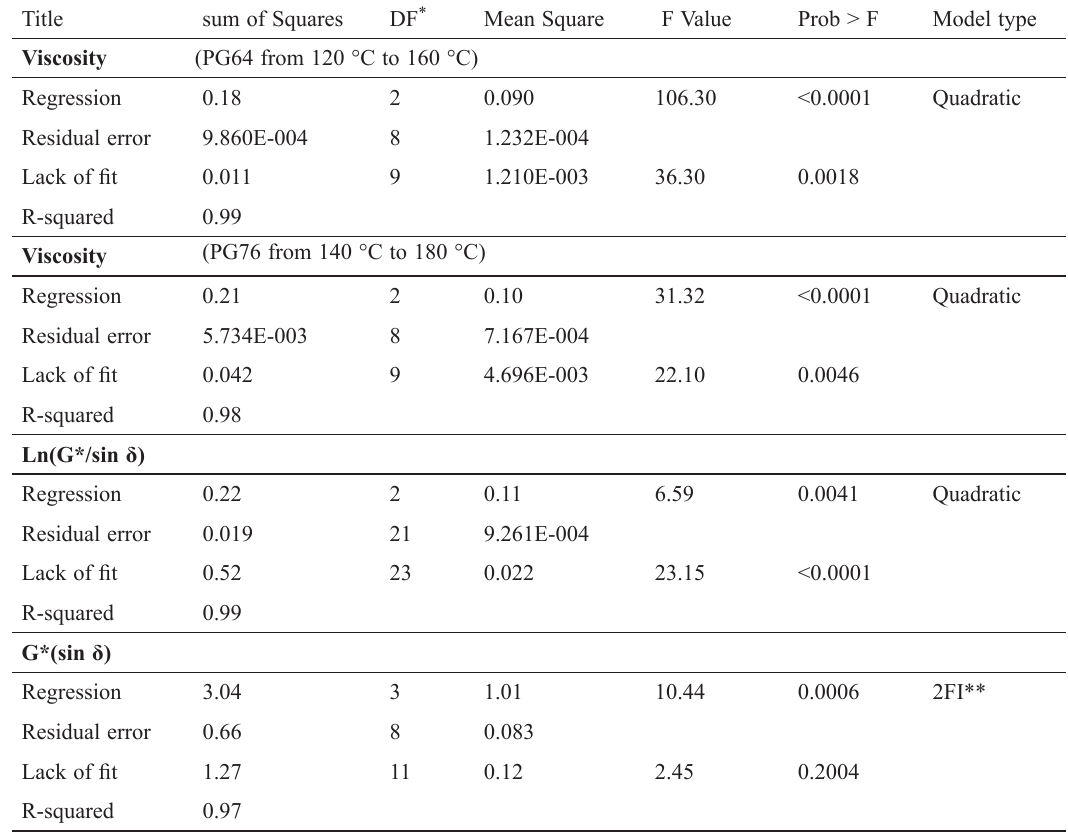
Table 8. Models proposed for prediction of Ln(G*/sin δ) and G*sin δ